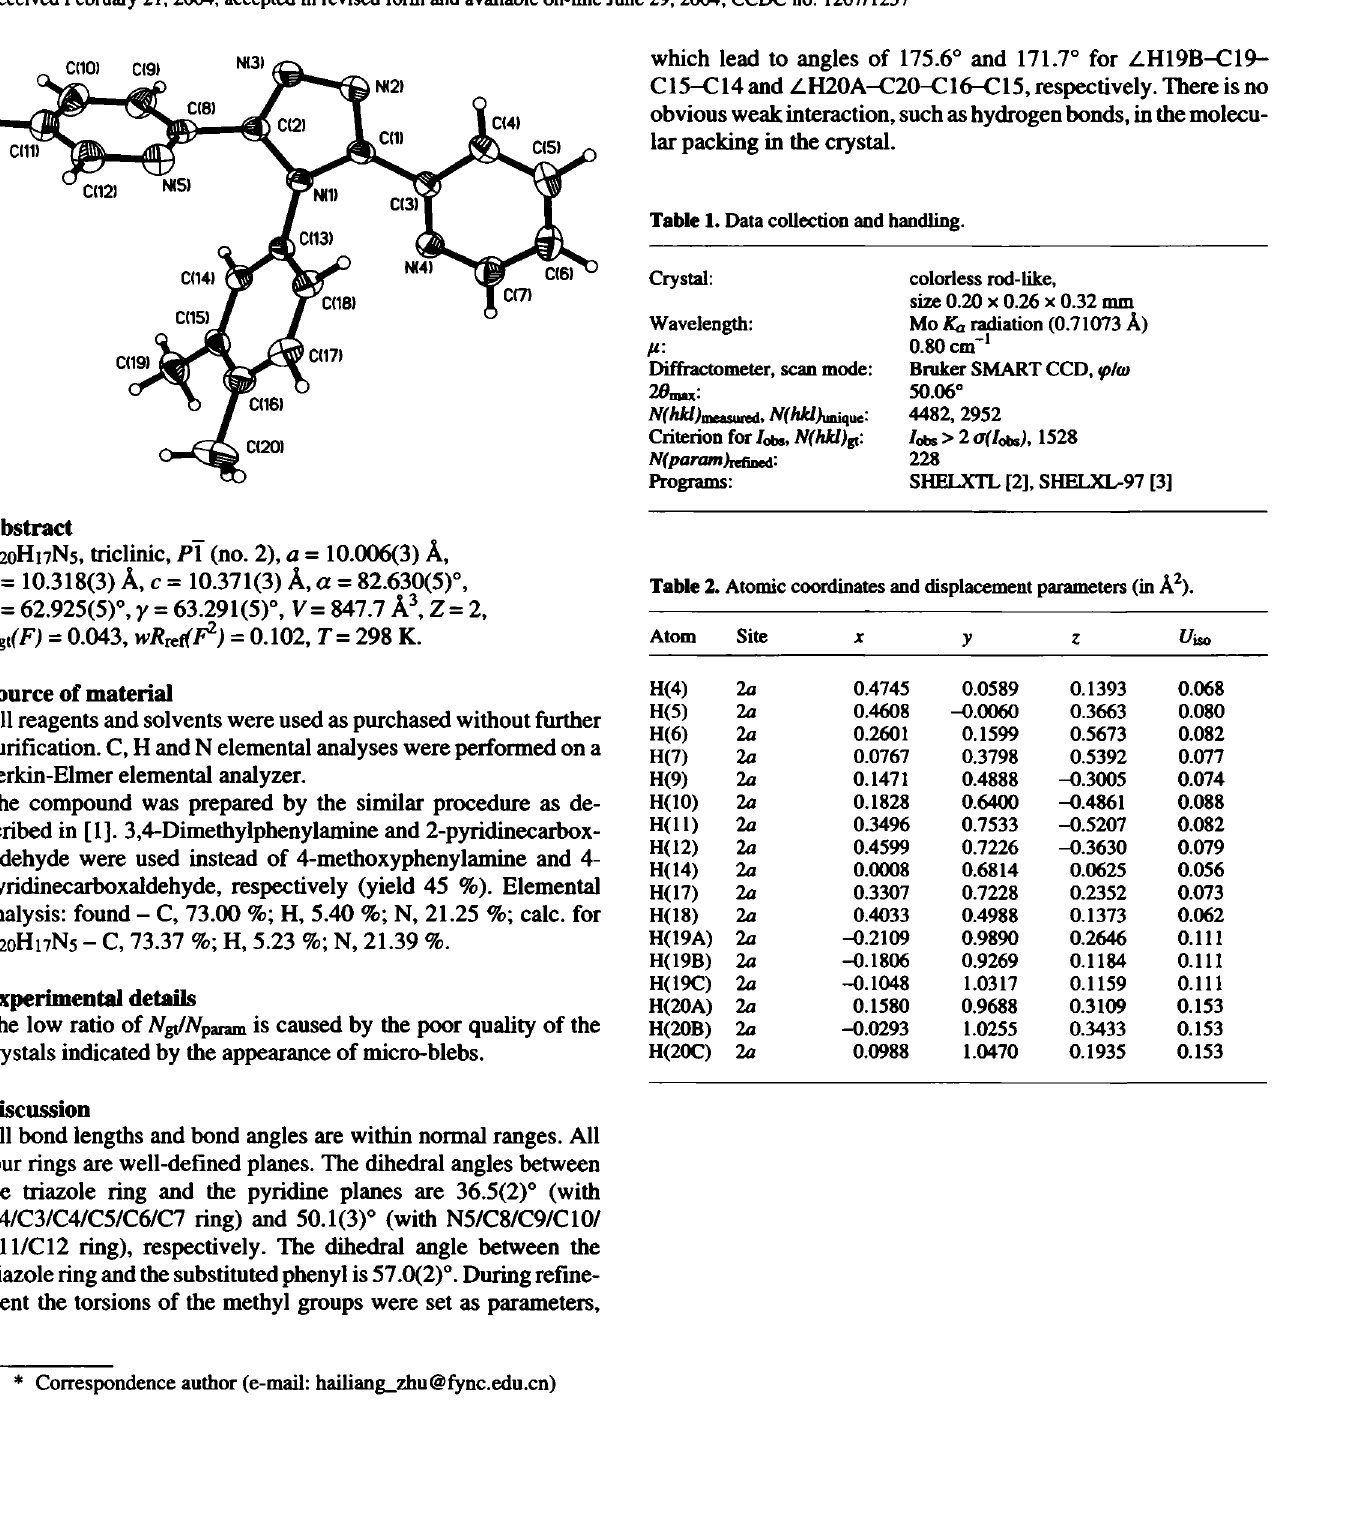
Table 1. Data collection and handling.